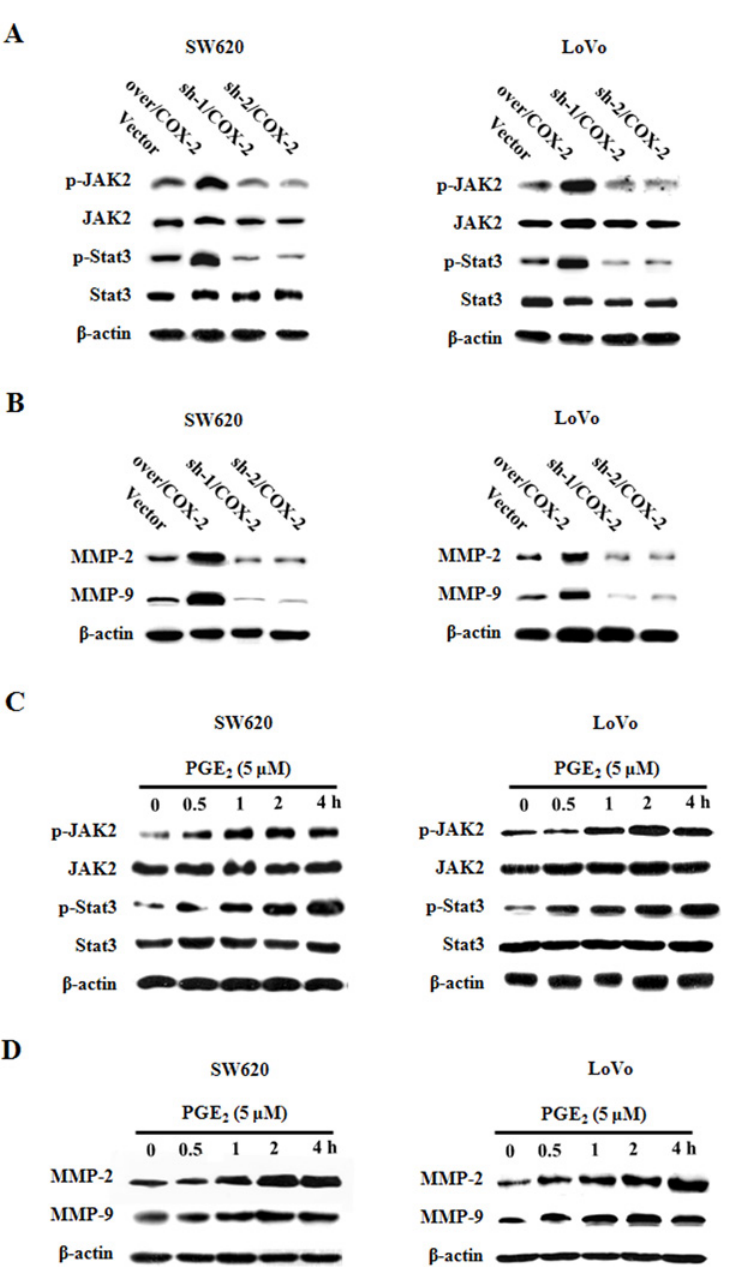
Fig 5. COX-2/PGE 2 regulates JAK2/STAT3 signaling in CRC cells. A. and B. Extracts from SW620 and LoVo cells transfected with COX-2 over-expression or shRNA construct were analyzed for pJAK2, JAK2, pSTAT3, STAT3, MMP-2, MMP-9 and beta-actin. C. and D. Extracts from SW620 and LoVo cells treated with PGE 2 for indicated durations were analyzed for pJAK2, JAK2, pSTAT3, STAT3, MMP-2, MMP-9 and beta- actin.